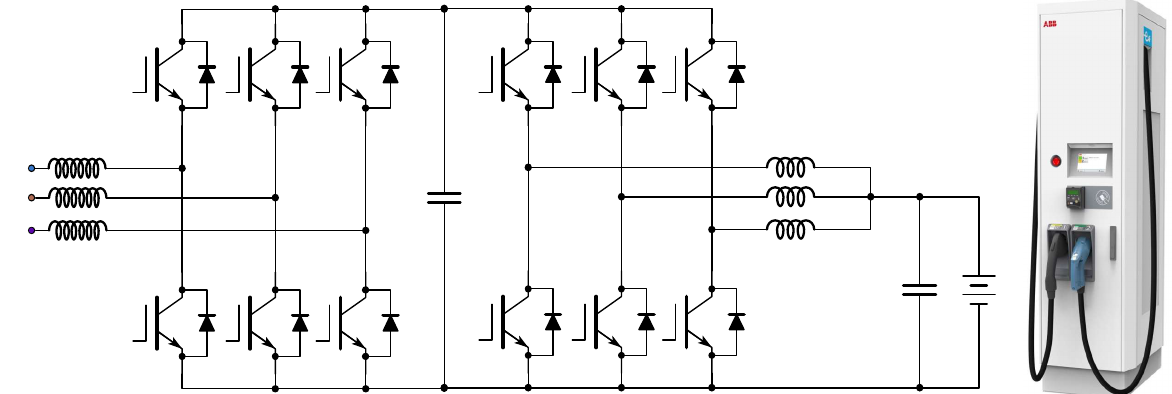
Figure 11. Modular 50 kW charger (designed by ABB).